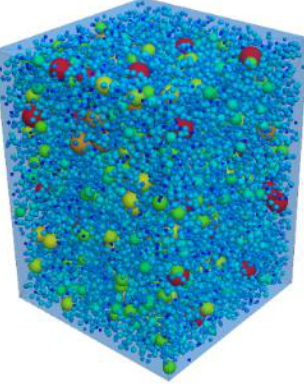
Figure 3. Formation of mixture